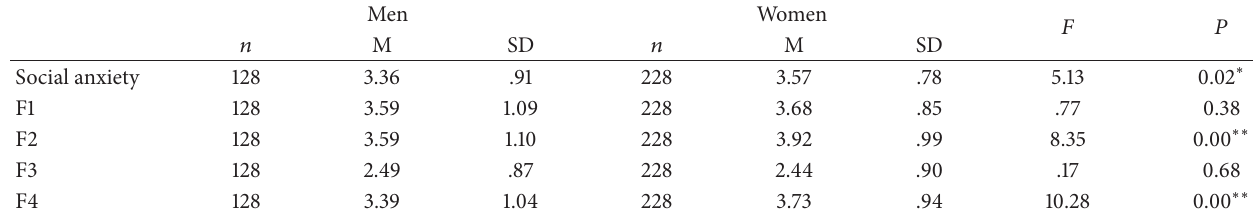
Table 2: Mean difference between women and men on social anxiety and its 4